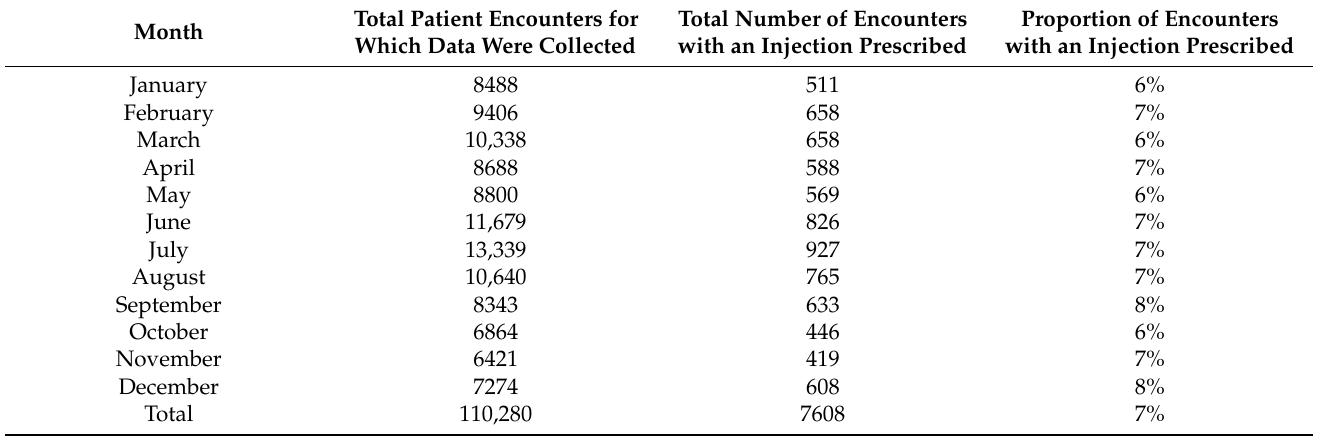
Table 4. Number and proportion of patient encounters with injections prescribed among outpatients of University Hospital, KNUST in 2021.